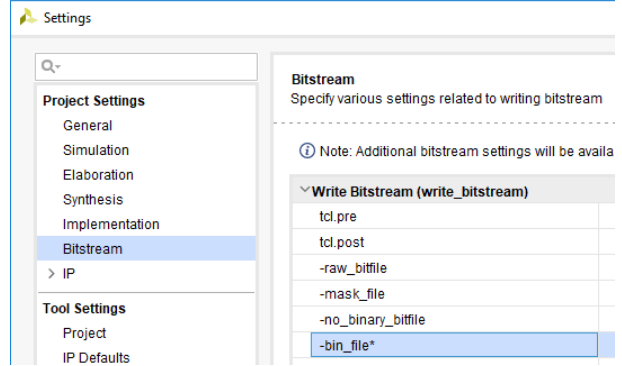
Figure 19. Flash memory device for Nexys 4 DDR.